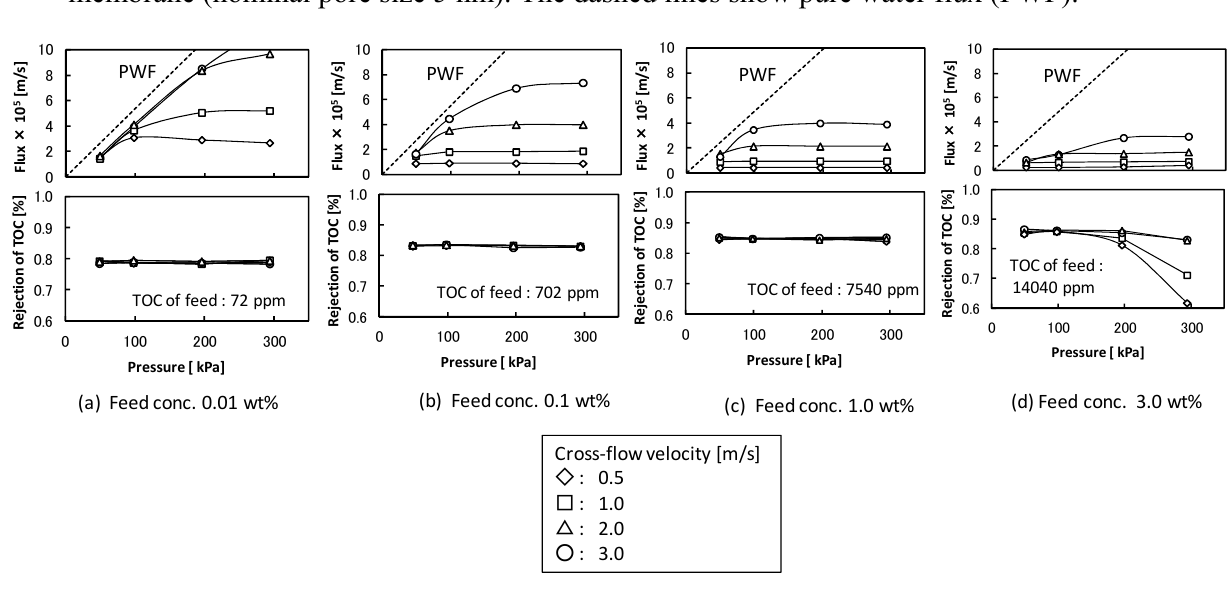
Figure 2. Effects of cross-flow velocity, filtration pressure, and feed concentration on the flux and the rejection of total organic carbon (TOC) components in ultrafiltration